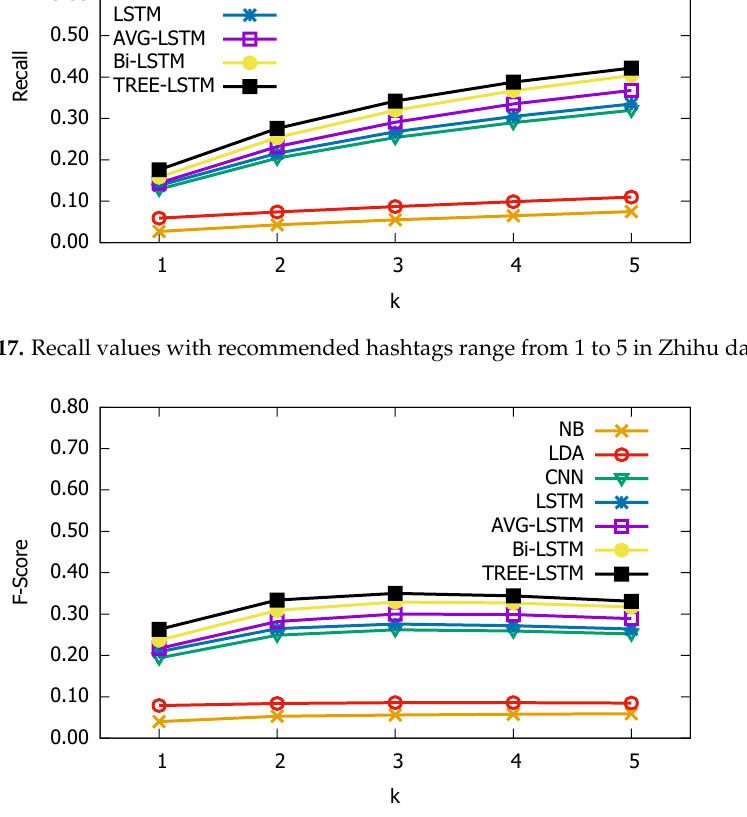
Figure 18. F1 values with recommended hashtags range from 1 to 5 in Zhihu dataset.